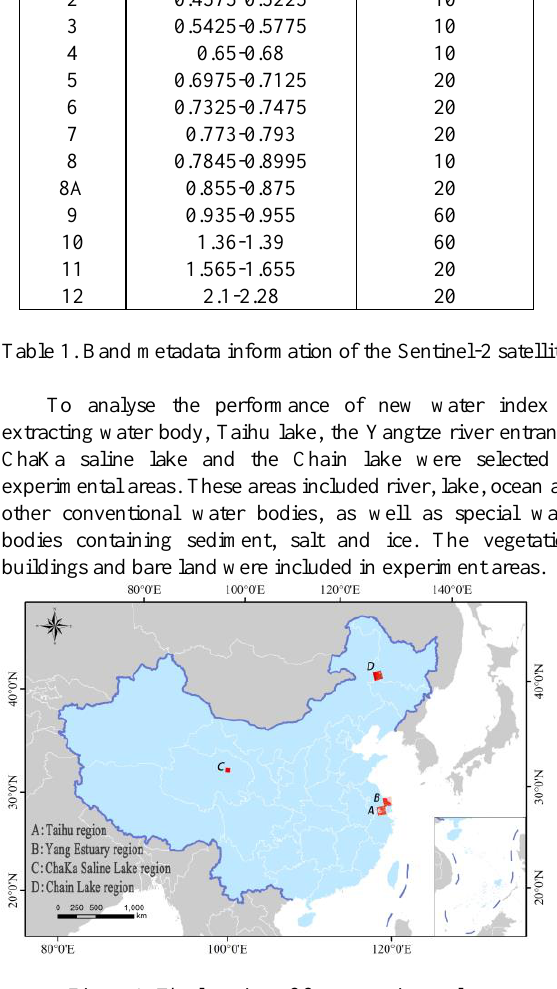
Figure 1. The location of four experimental areas